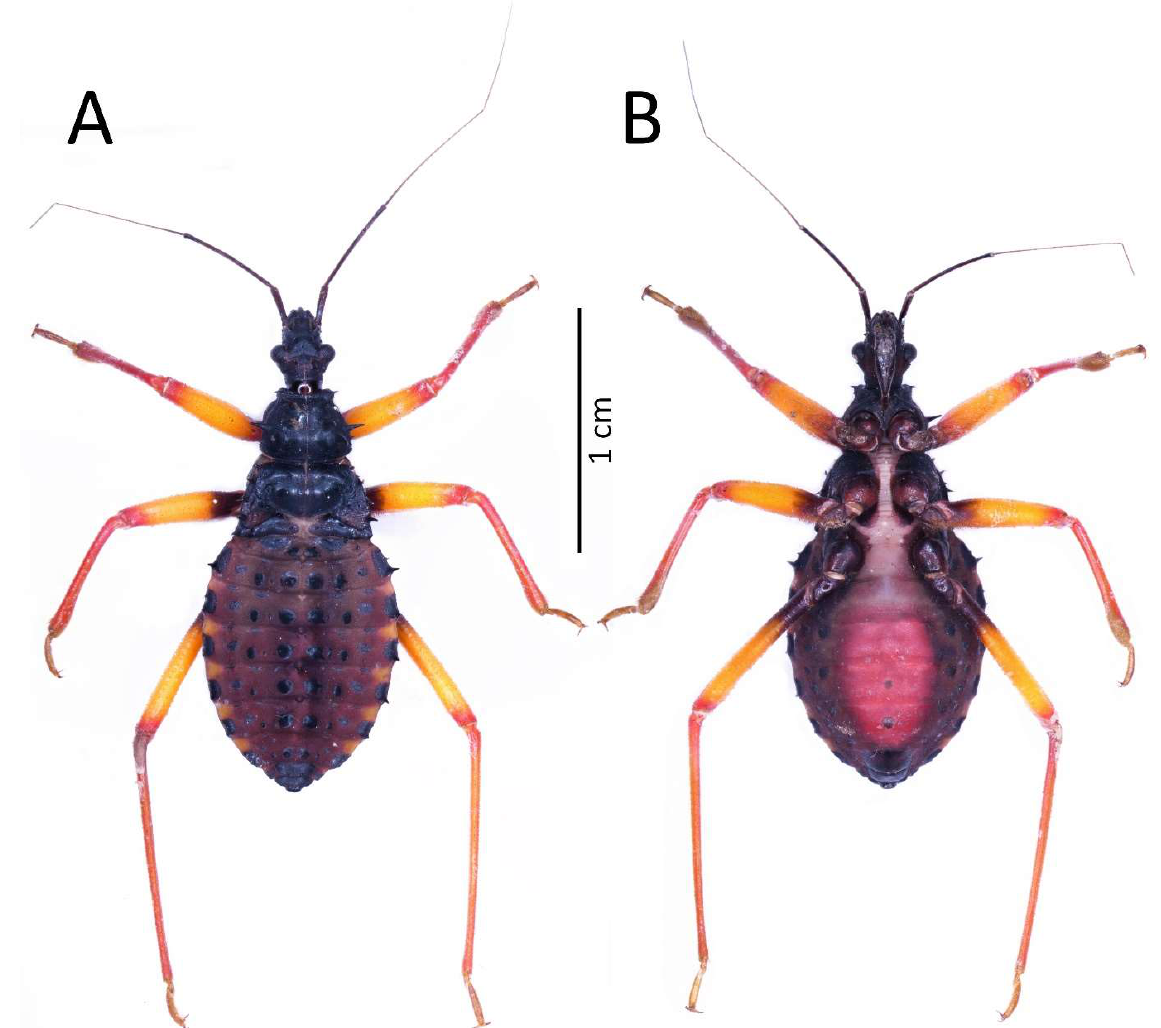
Figure 11. ( A ) Dorsal and ( B ) ventral habitus of the fourth instar of Psyttala horrida (Stål, 1865).